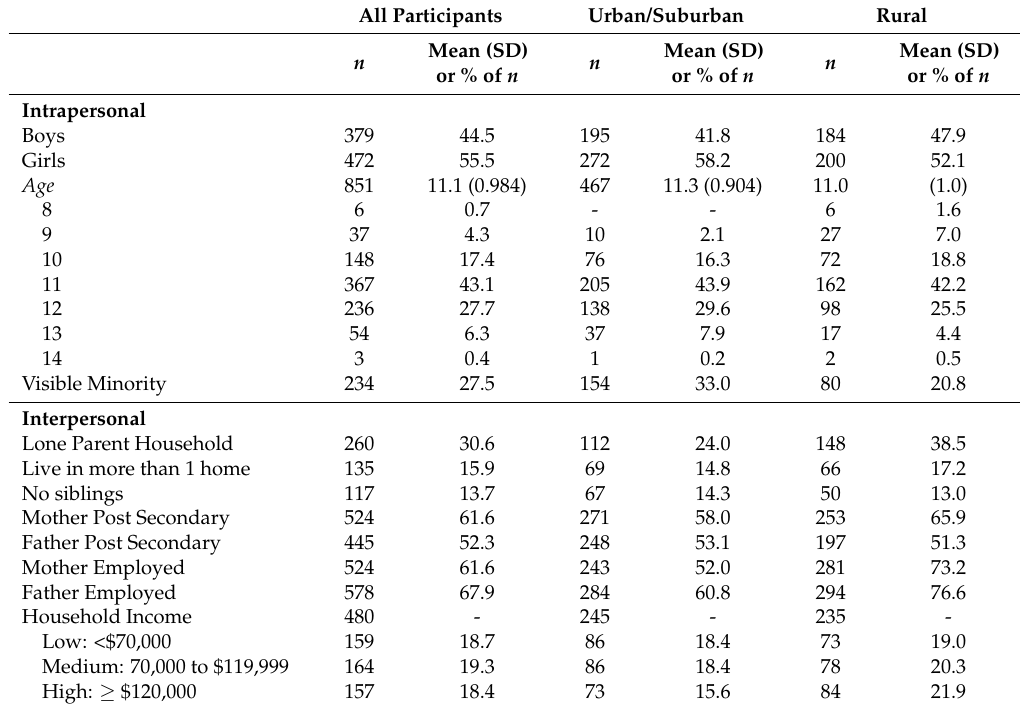
Table 2. Descriptive statistics of